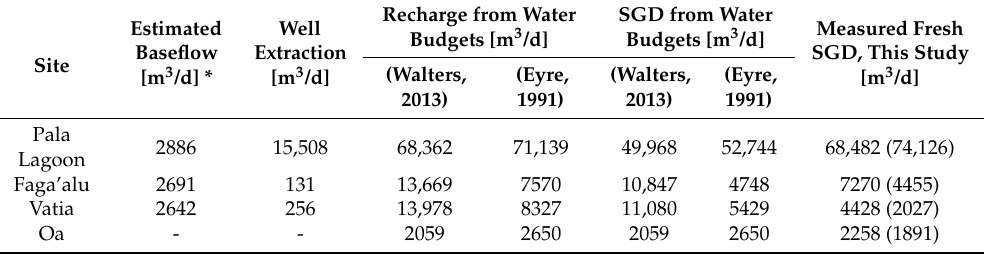
Table 5. Comparison of measured fresh SGD rates from this study to expected SGD amounts determined from previously developed water budget studies by Walters (2013) and Eyre and Walker (1991), shortened to (Eyre, 1991) in table heading. Values in parentheses are 1 σ standard